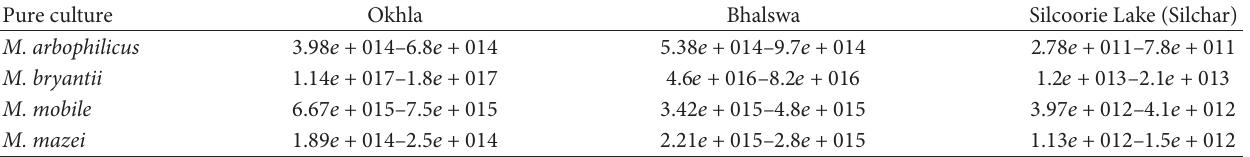
Table 5: Copy number of methanogens present per gram samples of Okhla and Bhalswa landfill site, Delhi, and Silcoorie Lake, Assam, India.